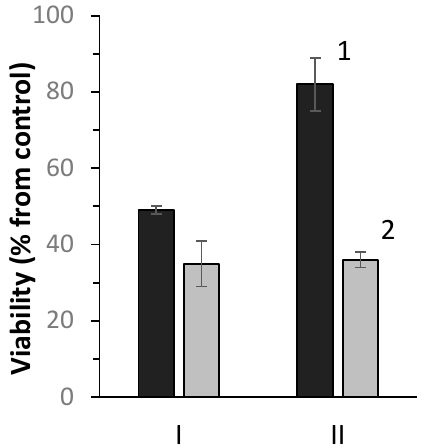
Figure 9. The SEM image shows aggregates of AuNPs (white color) synthesized by R. ruber IEGM 1135.